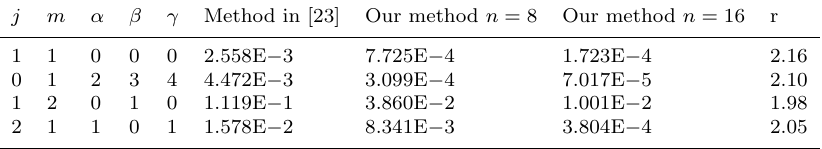
Table 3. Maximum absolute errors and the rate of convergence for Example 3 j m α